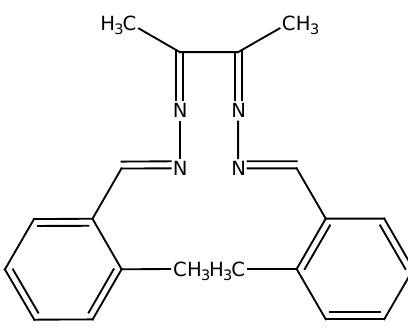
Figure 49. Bis(2-methylbenzaldehyde)butane-2,3-dihydrazone. The best performance was obtained with a membrane containing, 30% poly(vinyl chloride), 60% benzyl acetate, 6% TDSB and 4% sodium tetraphenyl borate. This sensor showed a very